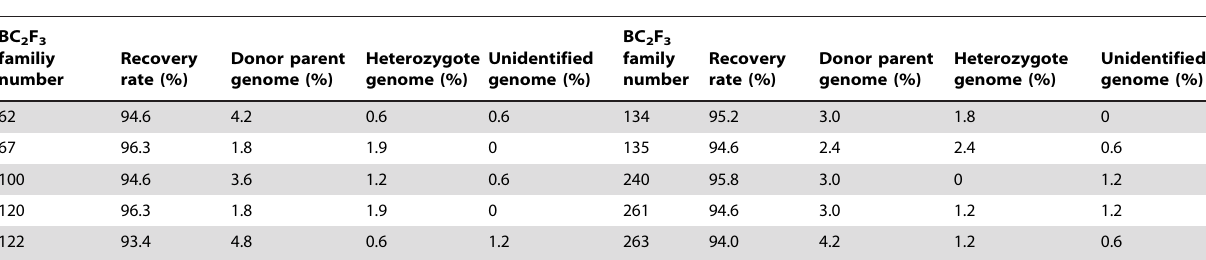
Table 4. Background analysis for 10 selected families in BC 2 F 3 .